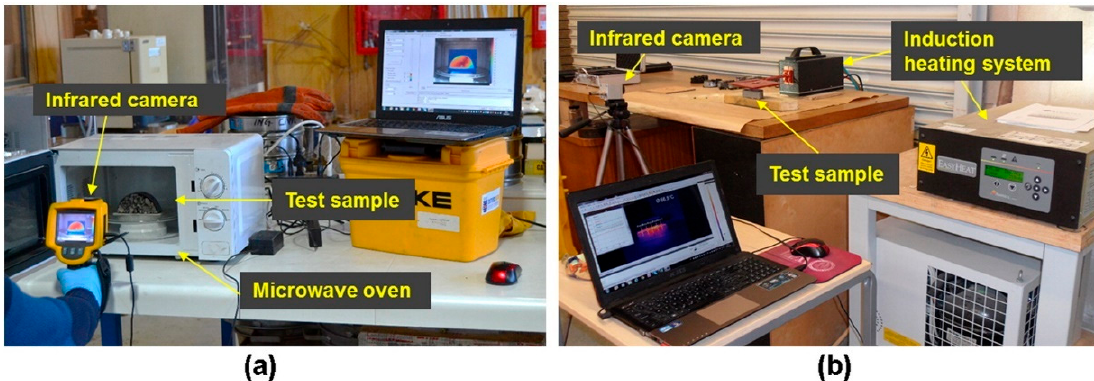
Figure 3. Heating devices: ( a ) microwave heating; ( b ) induction heating [7].